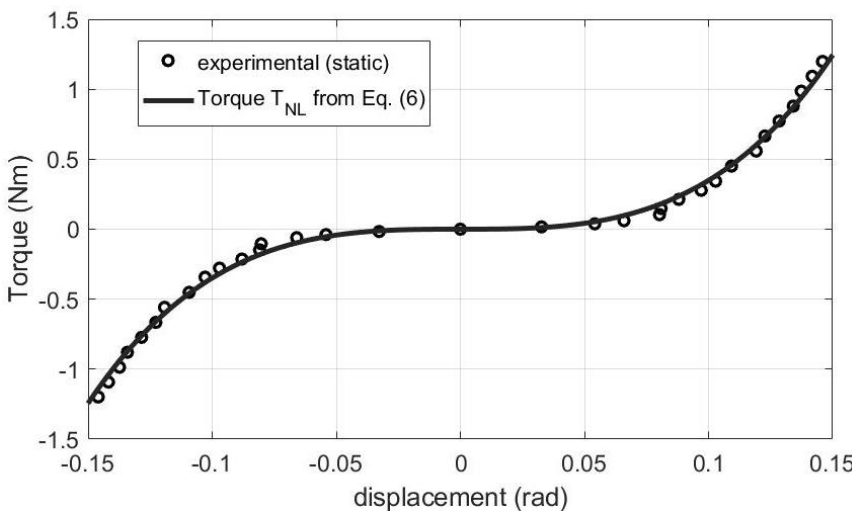
Figure 9. Theoretical torque curve computed with Equation (6) compared with statically identified torque profile given by Equation (6).